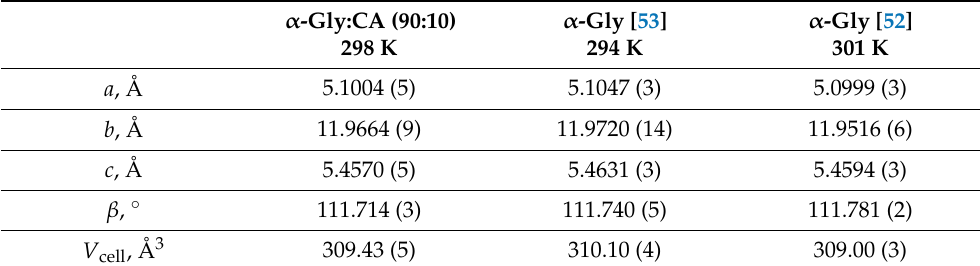
Table 2. Comparison of unit cell parameters a , b , c , angle β , and unit cell volume V cell in α -Gly:CA (90:10) and nominally pure α -Gly crystals from [52,53].